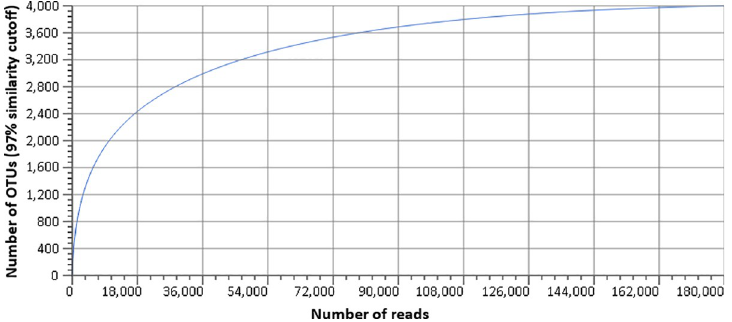
Fig 1. Rarefaction curve of annotated species richness within the Bovine URT bacterial 16S rDNA reference database.